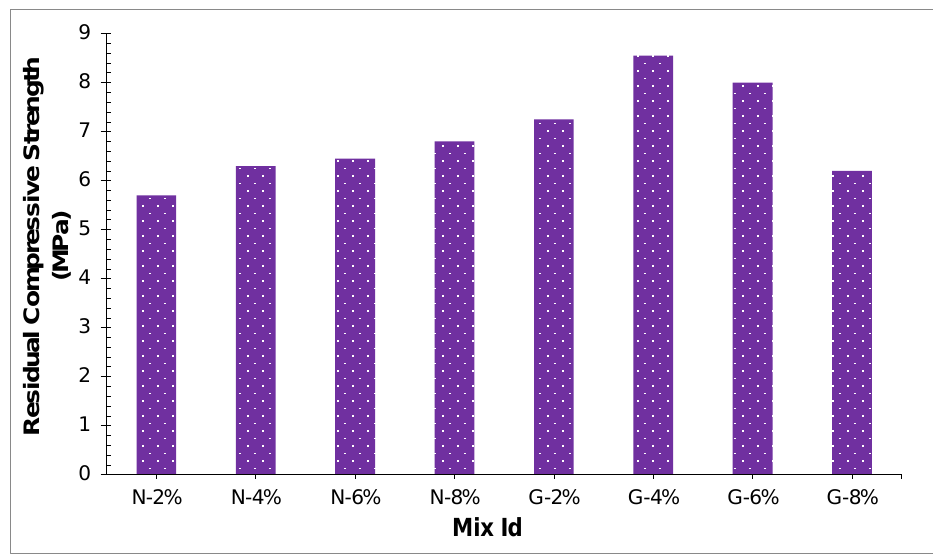
Figure 15. Residual compressive strength of concrete samples.